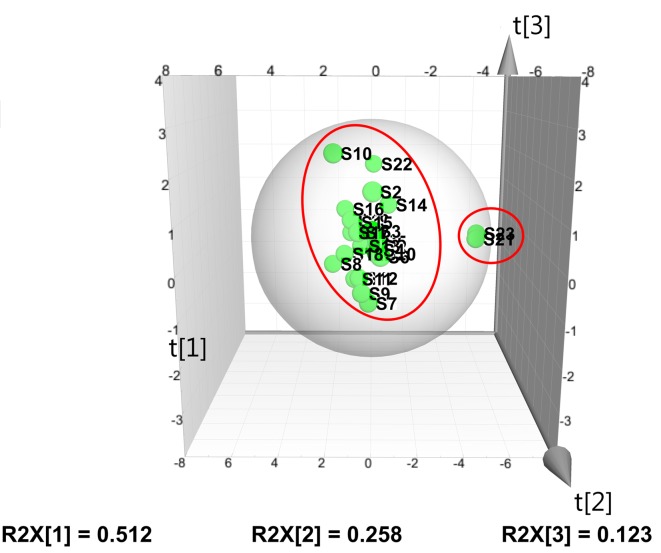
PCA score plot (given by SIMCA 13.0) of 23 batches of ISHI samples.